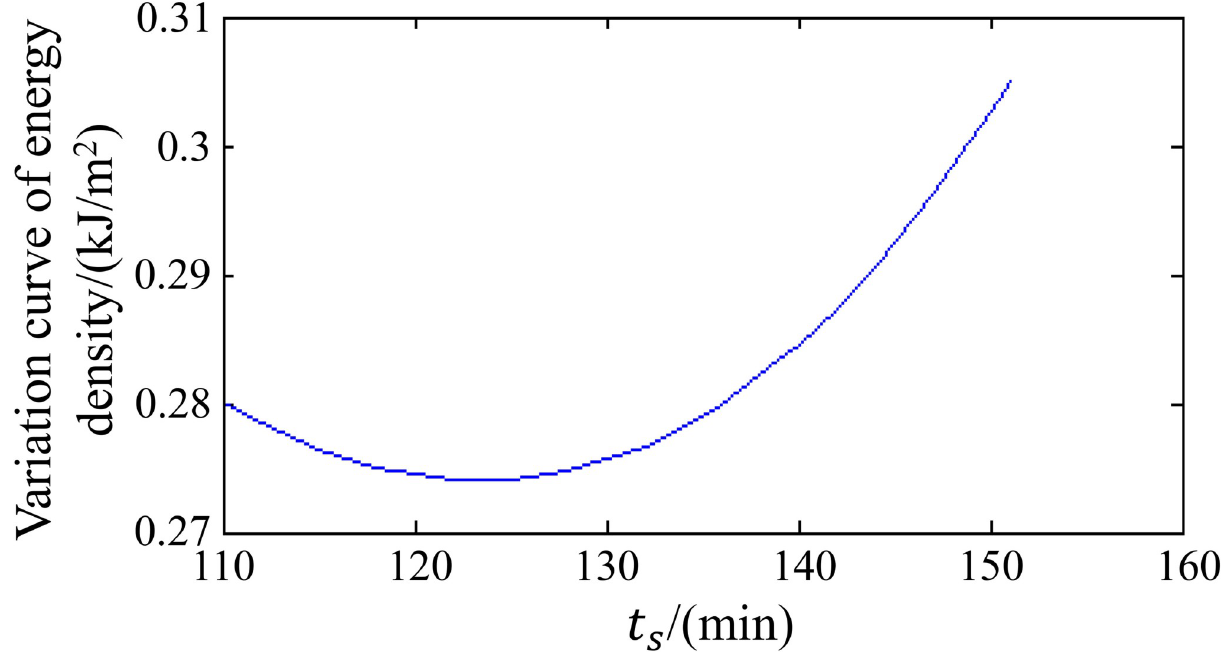
Fig 8. Time-dependent variation in energy